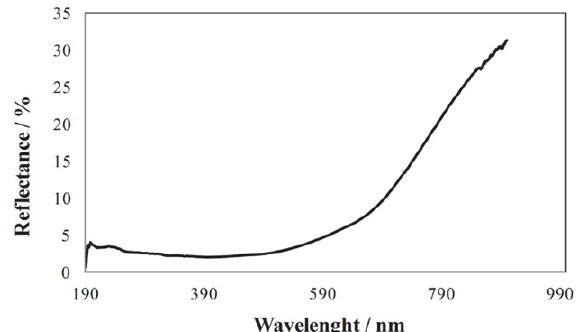
Figure 5. Diffuse reflectance spectra of AlCoFe 2 O 4